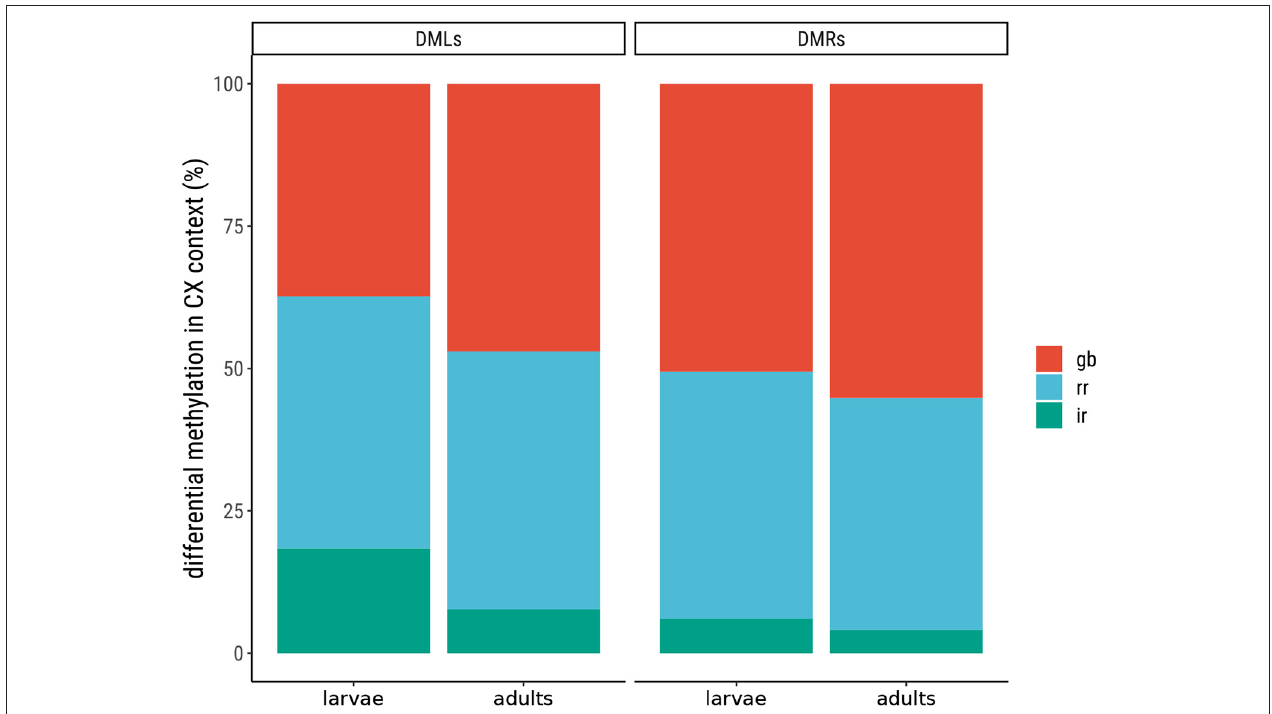
FIGURE 3 | Differential methylation in Manduca sexta according to genomic location. The differentially methylated loci (DMLs) and differentially methylated regions (DMRs) are classified by their location in the gene body (gb), regulatory region (rr), or intergenic region